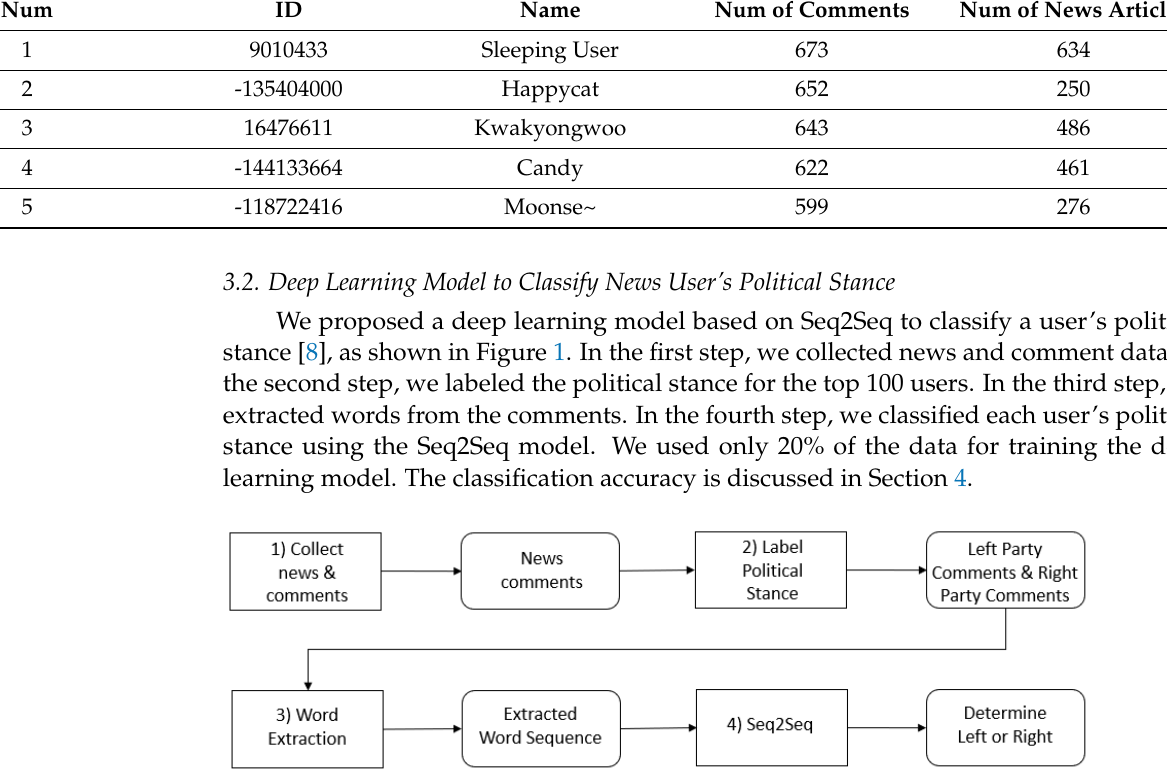
Figure 1. Process to classify each user’s political stance .